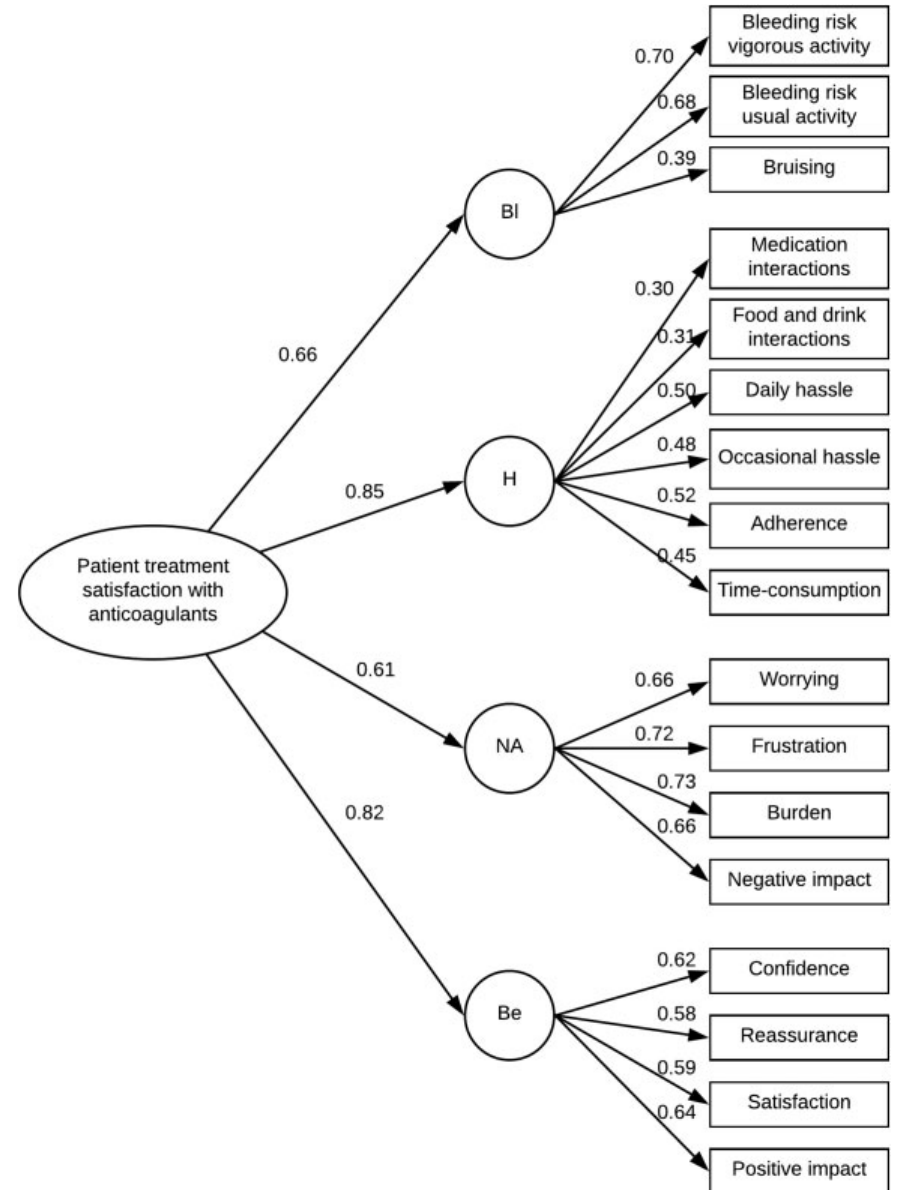
Fig. 3 Optimal factor model. Factor analysis showed that a four-factor model had the best fi t to the Danish version of the Anti-Clot Treatment Scale. The four domains were named Bleeding (Bl), Hassle (H), Negative affect (NA), and Bene fi ts (Be). Standardized factor loadings are indicated for each parameter.